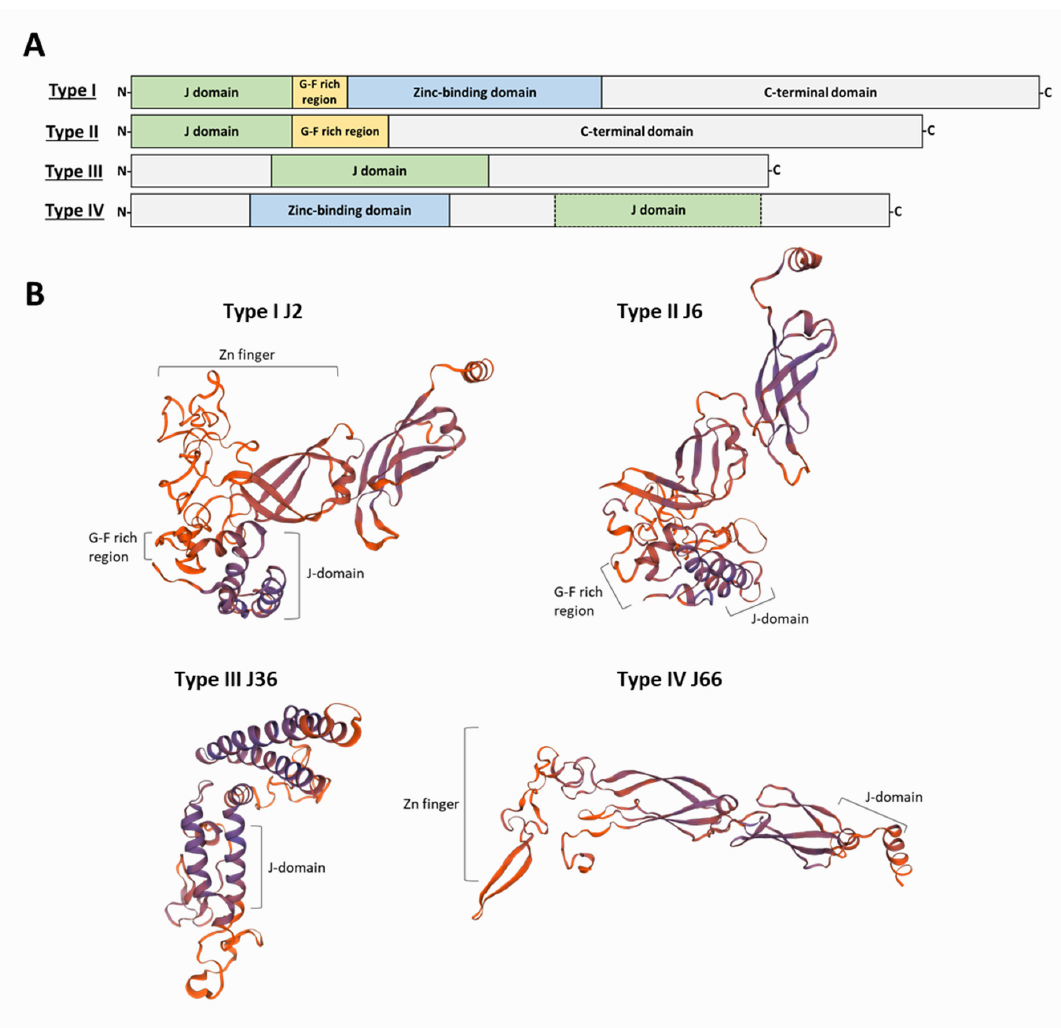
Figure 2. Classification of HSP40s into four types and representative L. infantum proteins for